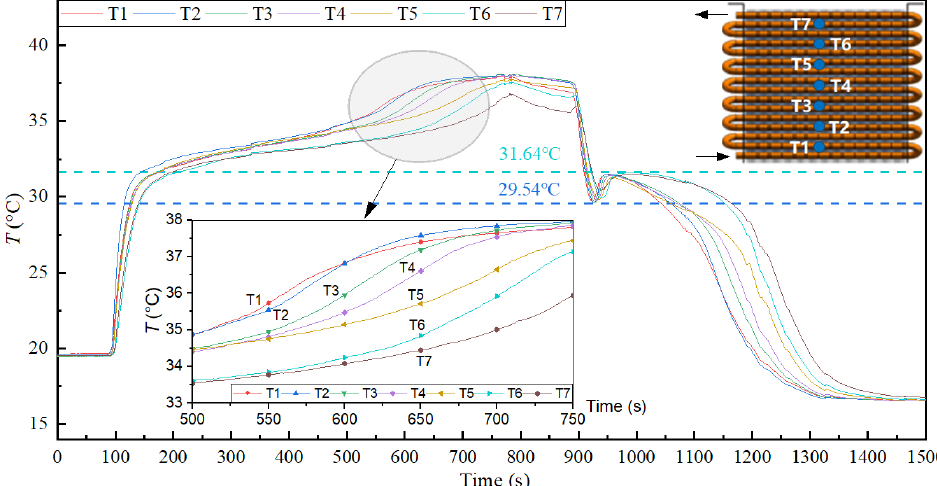
Figure 13. Longitudinal temperature distribution of PCM (10 wt.% EG).